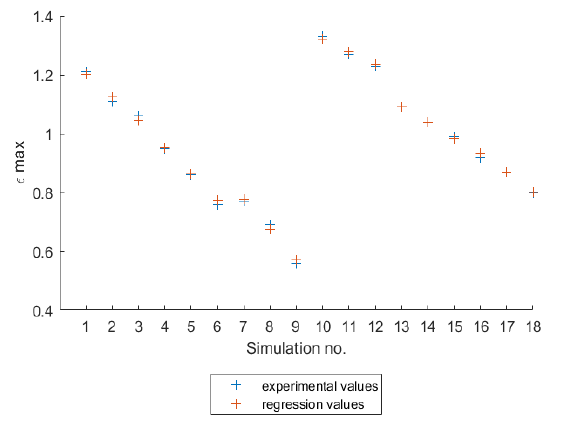
Figure 16. max ∈ Comparison experimental values and